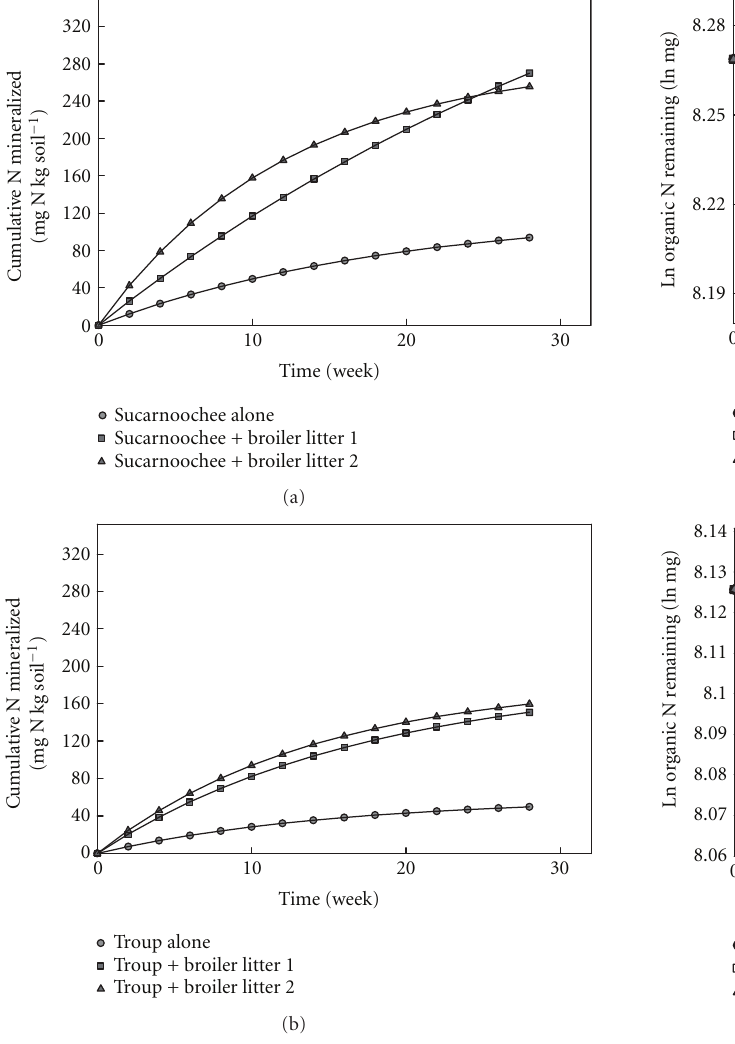
Figure 6: Natural log of organic N remaining in Appling (a) or Cecil (b) soils amended with broiler litter 1 or 2 as a function of time. relationship was found between N 0 and C/N ratio (data not